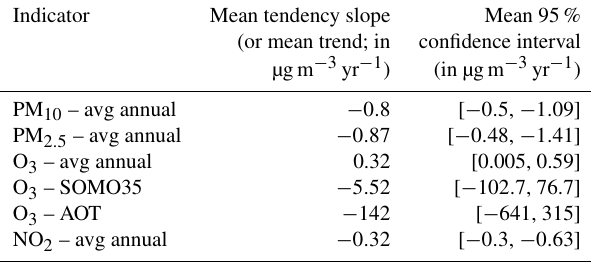
Table 5. Country-averaged slope and its 95% confidence interval.